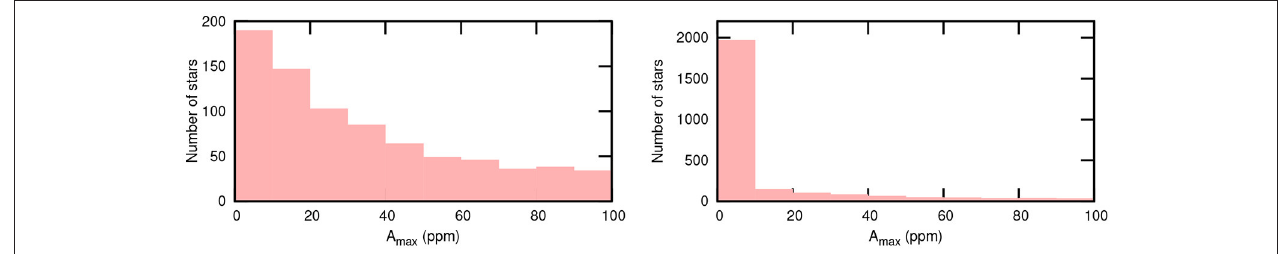
FIGURE 1 | (Left) The distribution of the maximum amplitude (ppm) in Kepler δ Sct stars with K p < 12.5mag in the instability box. (Right) The same distribution, but including all non-pulsating stars in the δ Sct instability box on the assumption that these “constant” stars actually pulsate with amplitude below the detection